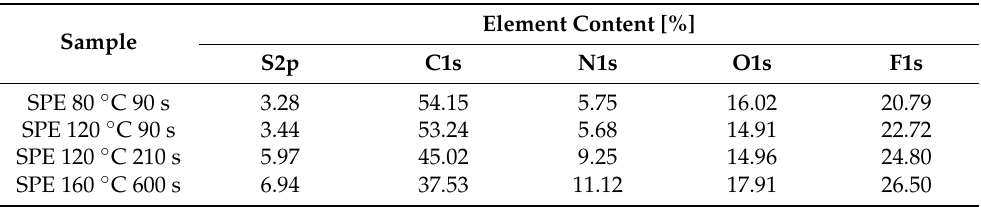
Table 2. Relative chemical compositions determined by